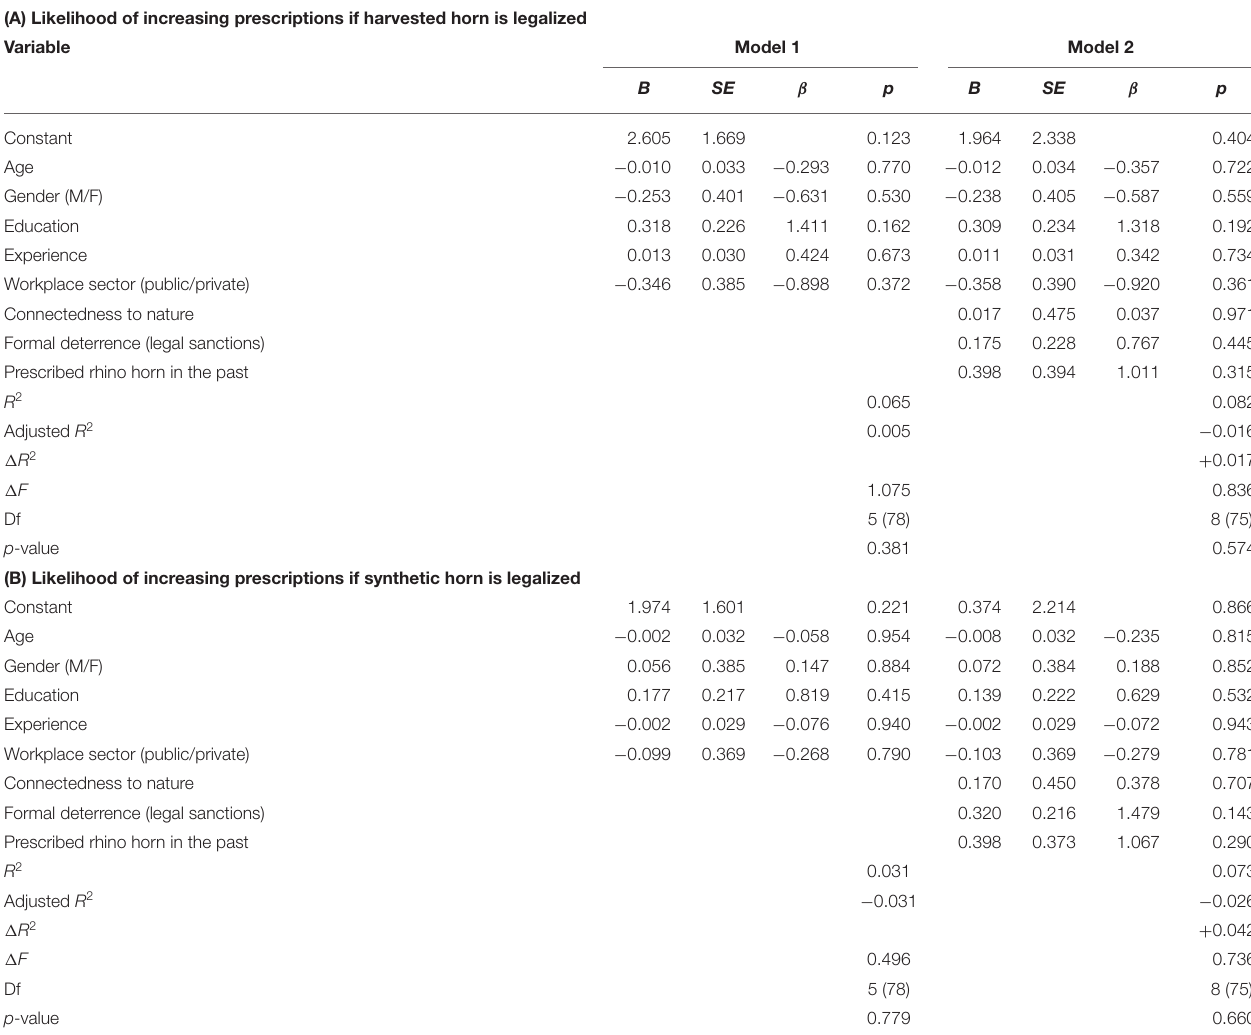
TABLE 2 | Hierarchical multiple regression for the effect of demographic factors, connectedness to nature, shame, and deterrence on TCM practitioners’ likelihood of increasing prescriptions of rhino horn if (A) harvested horn is legalized, and (B) synthetic horn is